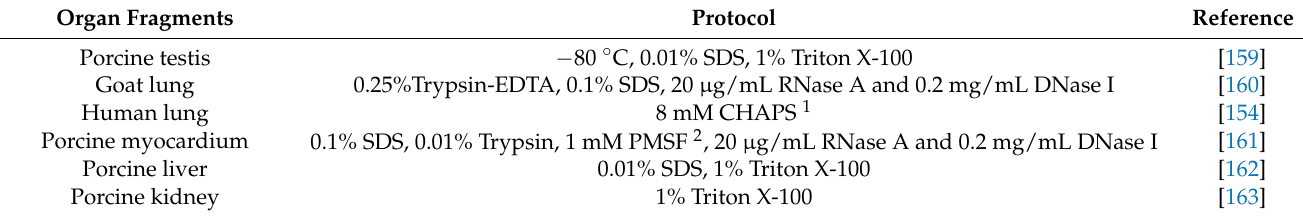
Table 1. Overview of the protocols developed for the decellularization of organ fragments and whole organs. Organ Fragments Protocol